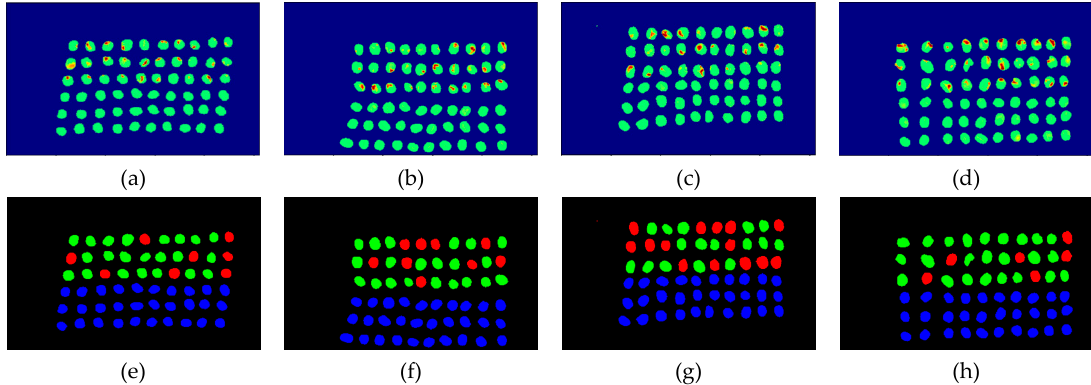
Figure 47. Results of green coffee bean CNN+SB_CTBS 20 bands. (a-d) CNN classification results, (e-h) final visual images.